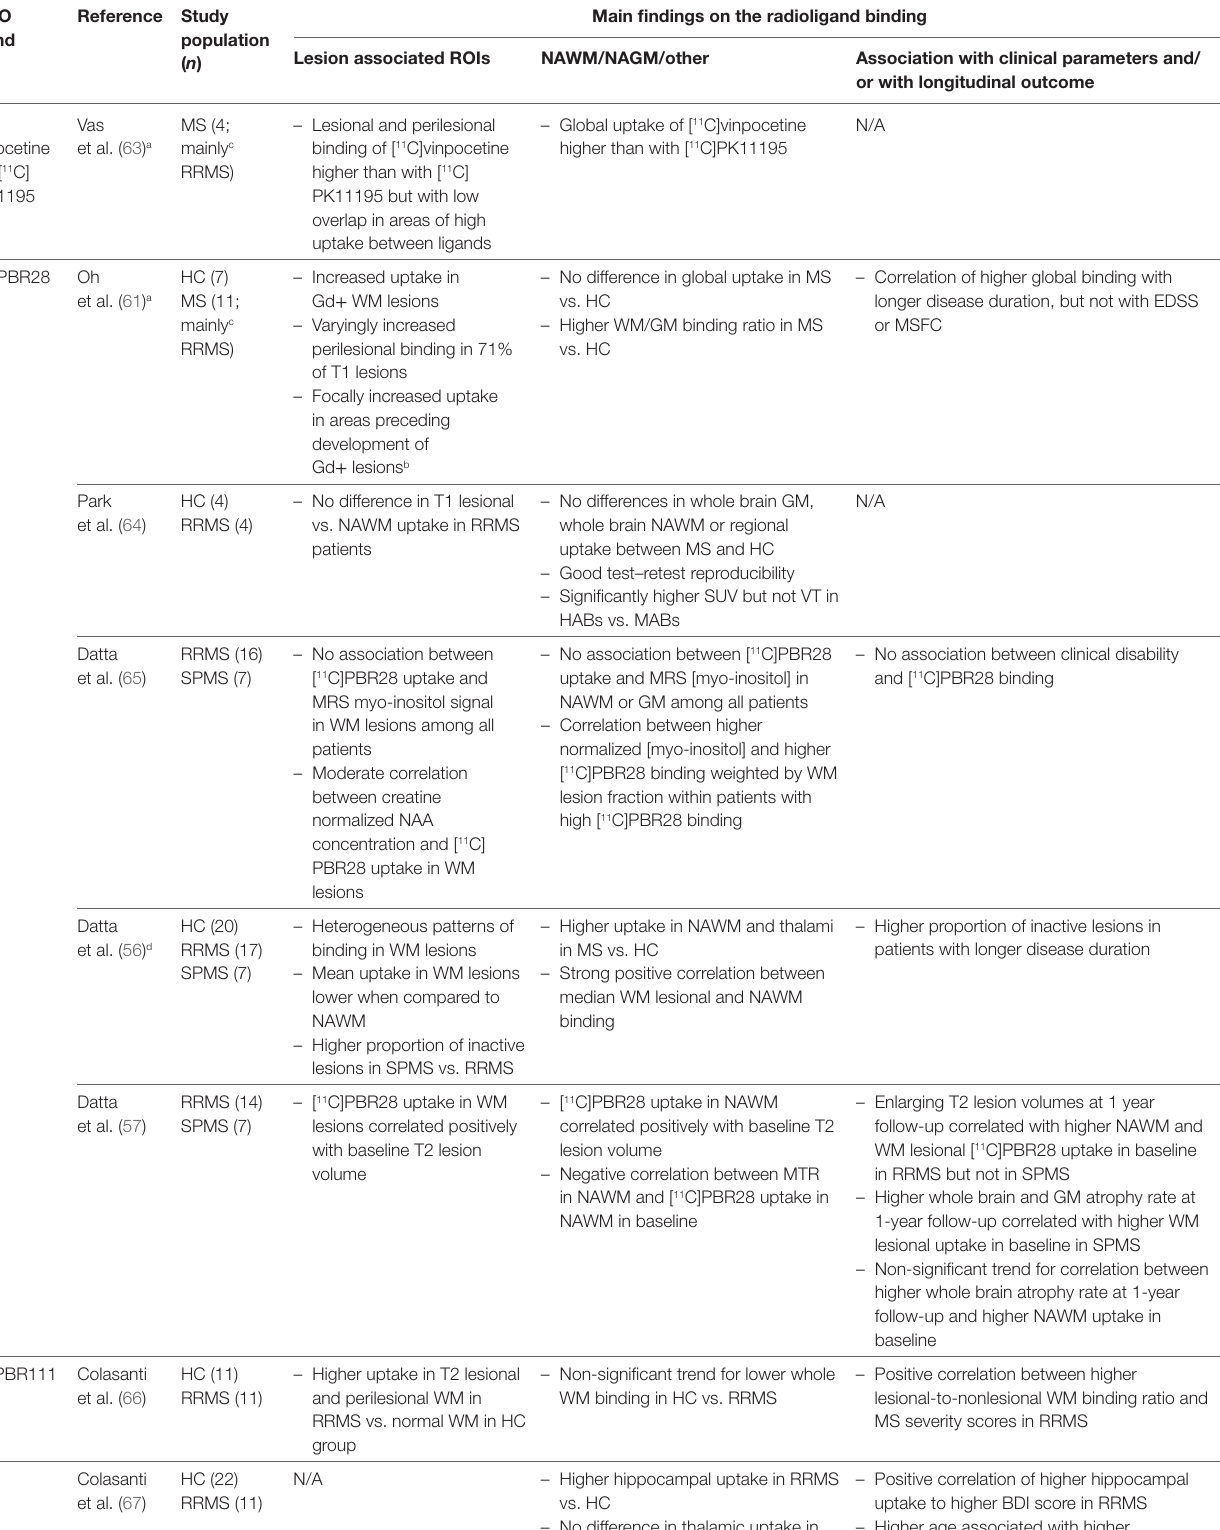
TABLe 2 | Human in vivo positron emission tomography (PET) imaging studies with second-generation TSPO ligands in multiple